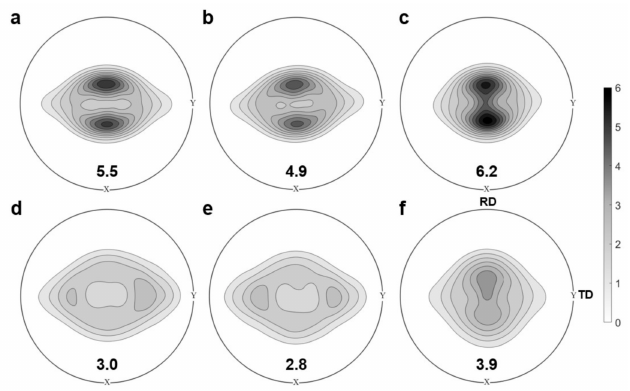
Figure 1. Recalculated (0002) pole figures of the ( a – c ) as-rolled and ( d – f ) annealed AZXW1000, 2000, and 3000 alloy sheets, respectively.